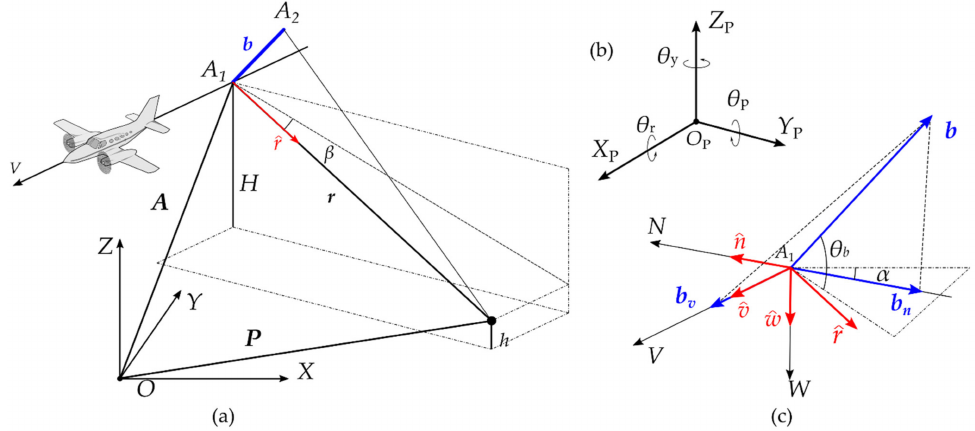
Figure 3. Three-dimensional geometry of airborne InSAR. ( a ) InSAR platform in the ECR coordinate system, ( b ) platform coordinate system, and ( c ) baseline vector in the MMC